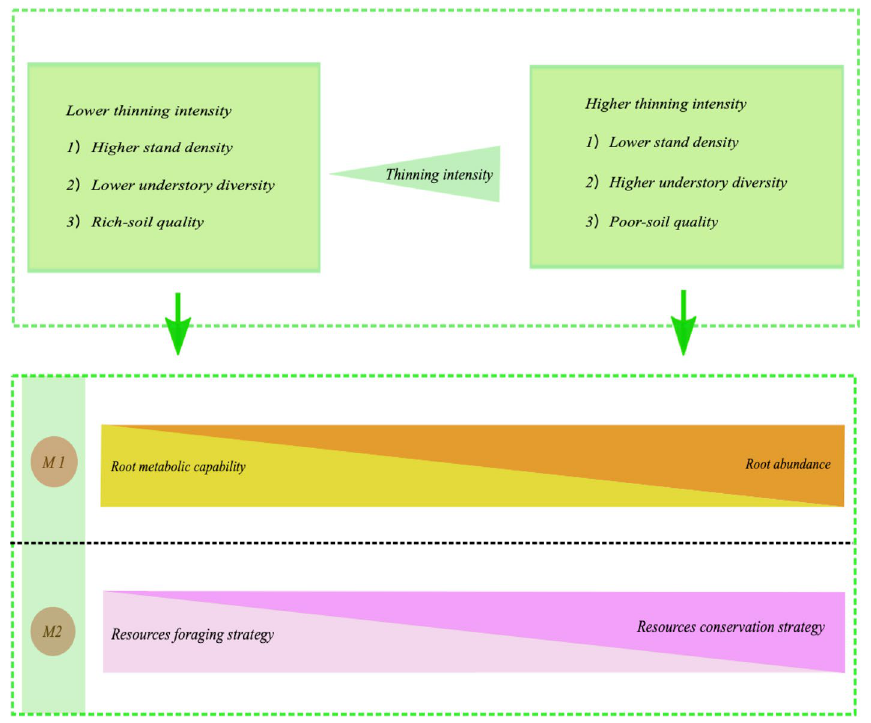
Figure 5. The absorptive root acclimation strategies of Chinese fir along thinning intensity. M1: the trade-off between root abundance and root metabolic capability; M2: the trade-off between resources foraging strategy and resources conservation strategy. The triangles with different colors indicate that the values of indices within triangles increase with increasing width of the